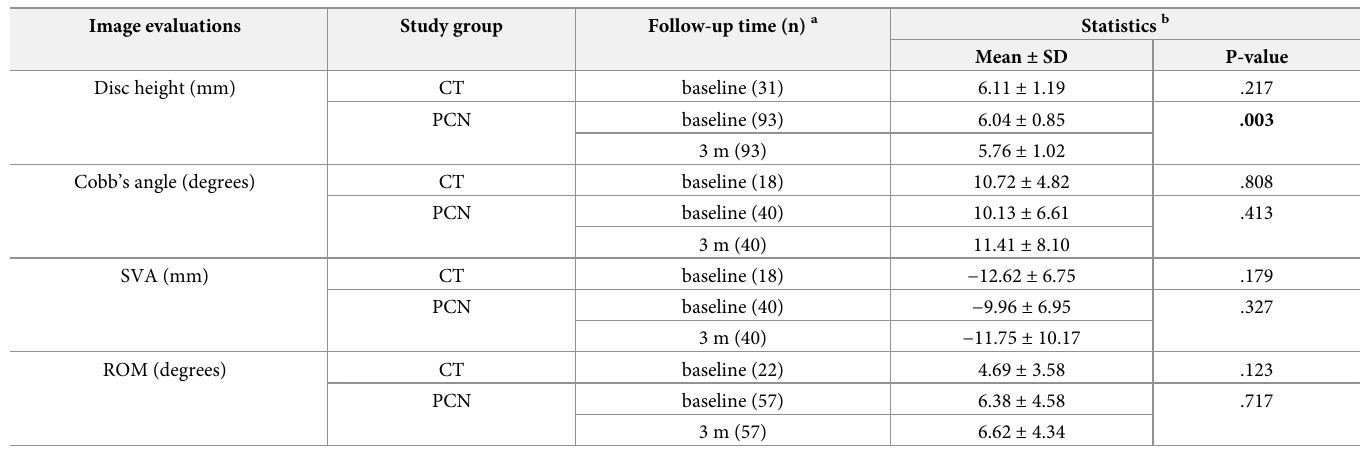
Table 2. Estimated image parameters.